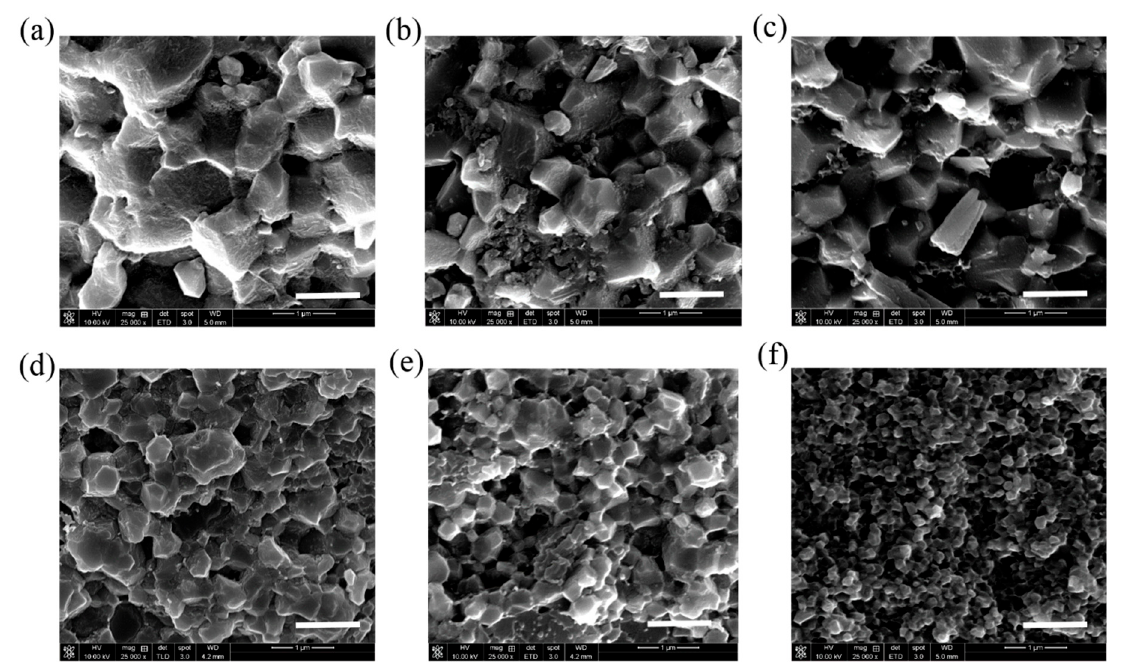
Figure 5. SEM micrograph of sintered ( a ) HA, ( b ) 0.1 wt.% r-GO/HA, ( c ) 0.5 wt.% r-GO/HA, ( d ) 1 wt.% r-GO/HA, ( e ) 2 wt.% r-GO/HA, and ( f ) 5 wt.% r-GO/HA NCPs. The scale bar is 1 µ m.